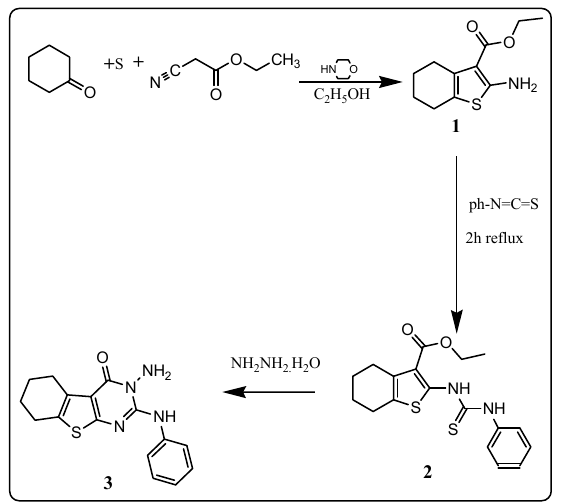
Scheme 1. Scheme for synthesis of the target